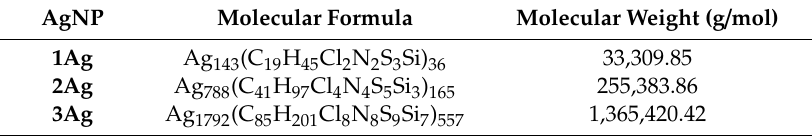
Table 1. Characteristics of the studied AgNPs.